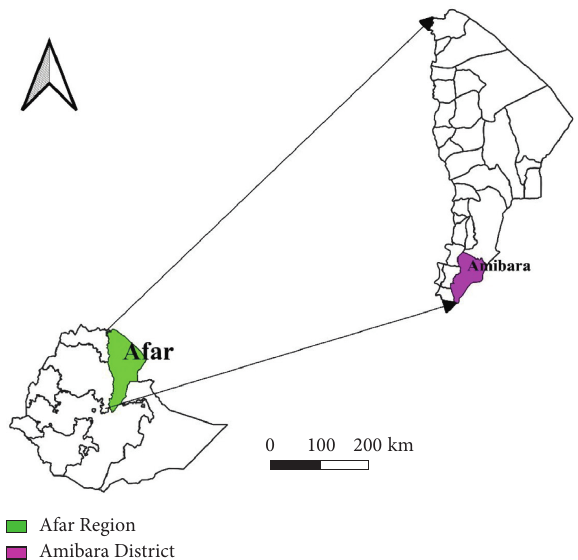
Figure 1: Map showing proposed study district. Source: Diva